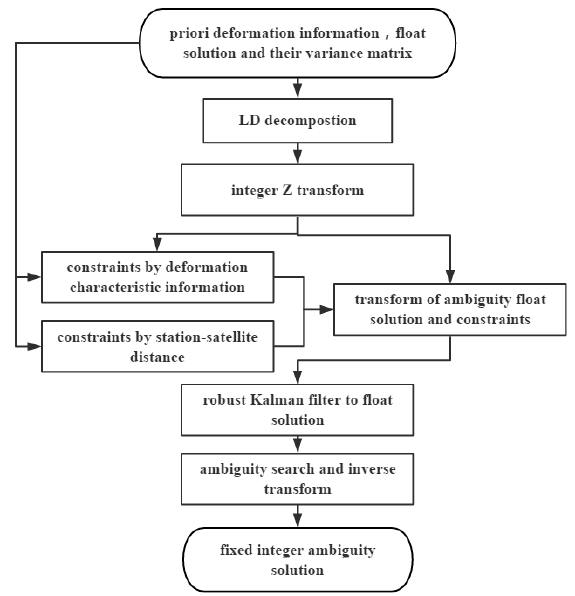
Figure 1. Flowchart for the proposed constrained Multi-GNSS MLAMBDA Method.